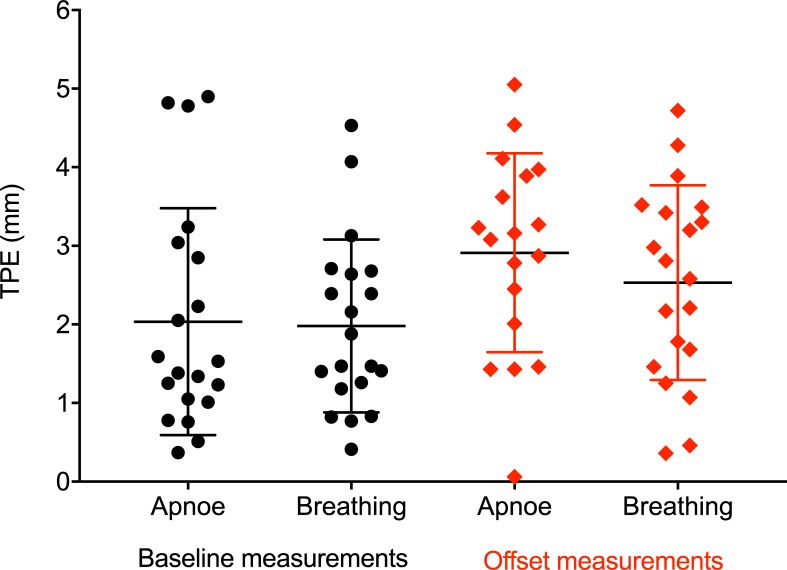
Targeting accuracy according to breathing modality.Bars indicate means and standard deviations. TPEPE = Target Positioning Error, Primary Endpoint.